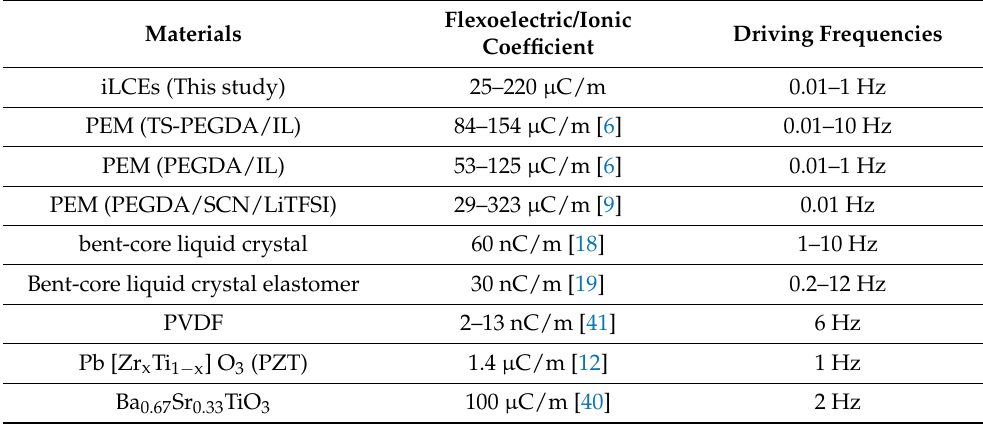
Table 1. Comparison of flexo-ionic coefficient and limit of the driving frequencies of iLCEs with ionic electroactive polymers, bent-core liquid crystals, and insulating polymers and